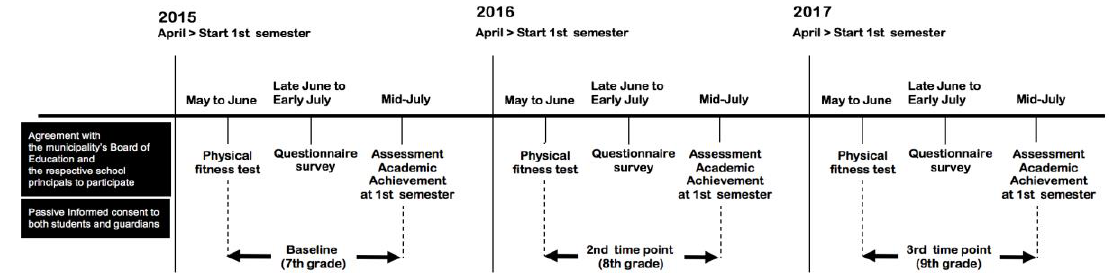
Figure 1. Procedure of this study.